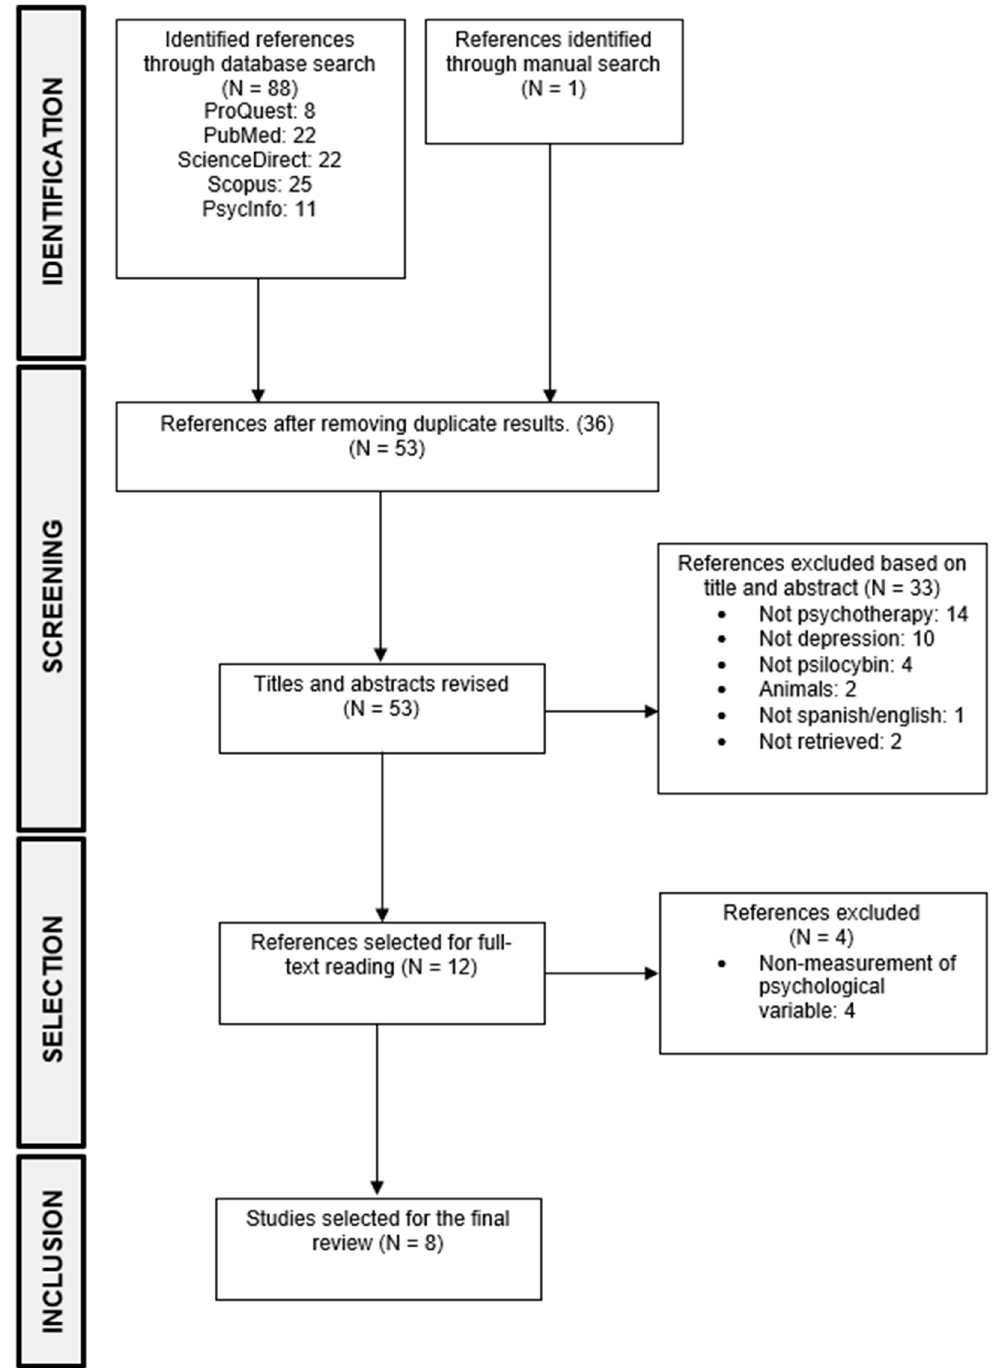
Figure 1. PRISMA fl ow diagram of the study